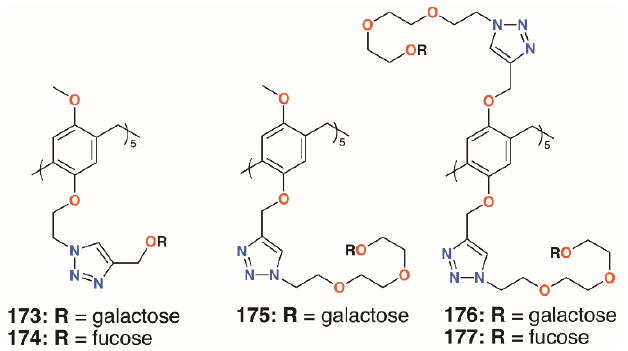
Figure 28. Vidal’s glycosylated pillar[5]arenes.